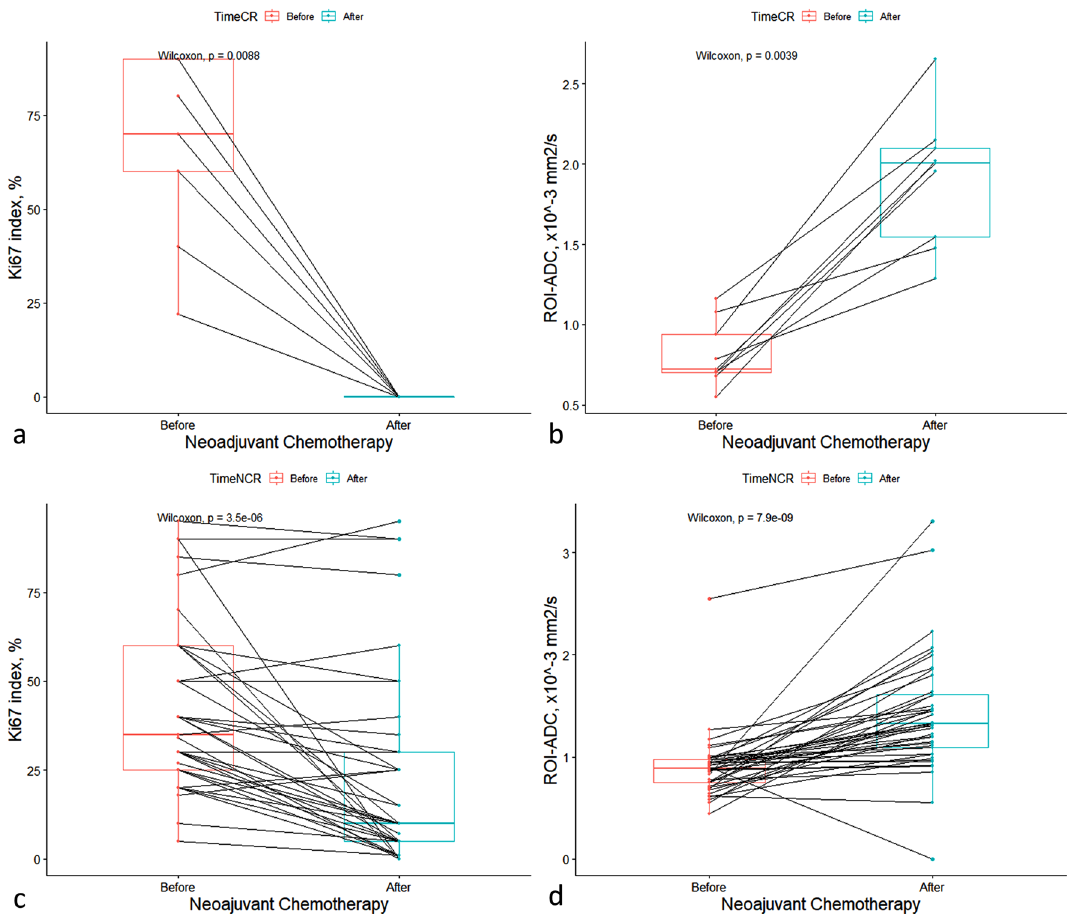
Figure 3. Changes in the ROI-ADC and Ki-67 index before and after neoadjuvant chemotherapy (NACT) in pathologic complete response (pCR) ( a , b ) and non-pCR ( c , d ) patients. ROI region of interest, ADC apparent diffusion